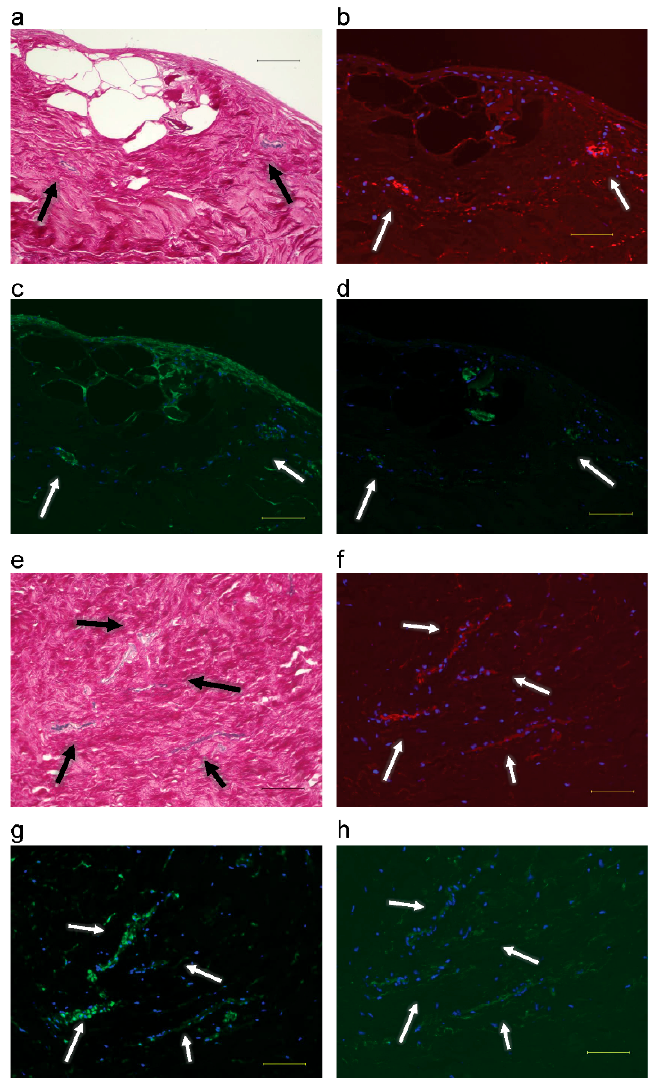
Figure 4. Observation of microvessels in serial sections of periosteum after explant culture: ( a – d ) At 6 weeks. Scale bar: 100 μ m. ( a ) EVG staining; ( b ) FBXW2: red, DAPI: blue; ( c ) α SMA: green, DAPI: blue; ( d ) Osteocalcin: green, DAPI: blue. ( e – h ) At 7 weeks. Scale bar: 100 μ m; ( e ) EVG staining; ( f ) FBXW2: red, DAPI: blue; ( g ) α SMA: green, DAPI: blue; ( h ) Osteocalcin: green, DAPI: blue. Arrows: blood vessels.